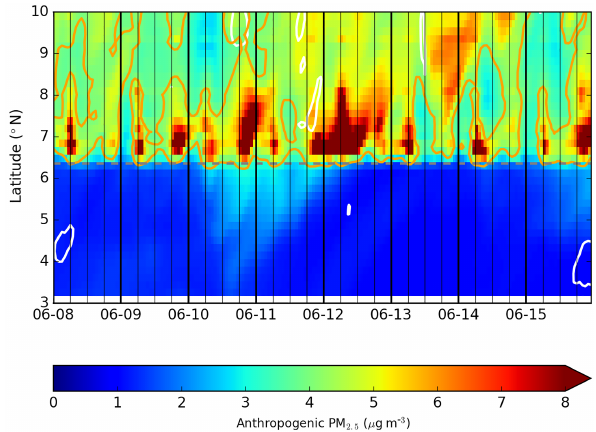
Figure 9. Time–latitude average (Hovmöller) of surface anthro- pogenic PM 2 . 5 concentration (µgm − 3 ) averaged along a merid- ional transect between 2 and 3 ◦ E from 1 to 17 June 2016. Black vertical bars delimit the periods of the day (00:00, 06:00, 12:00, 18:00UTC). White isocontours present precipitation rate of 3.0mmh − 1 . Orange isocontour represents the surface anthro- pogenic PM 2 . 5 concentration of 4µgm − 3